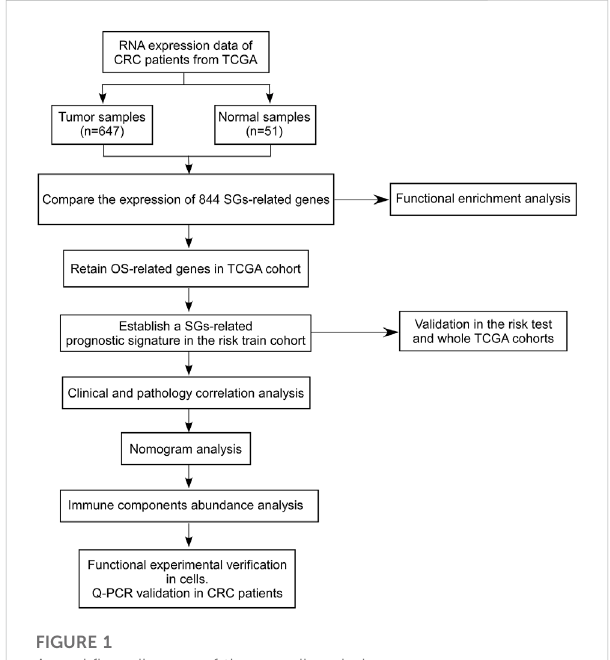
FIGURE 1 A work fl ow diagram of the overall analysis